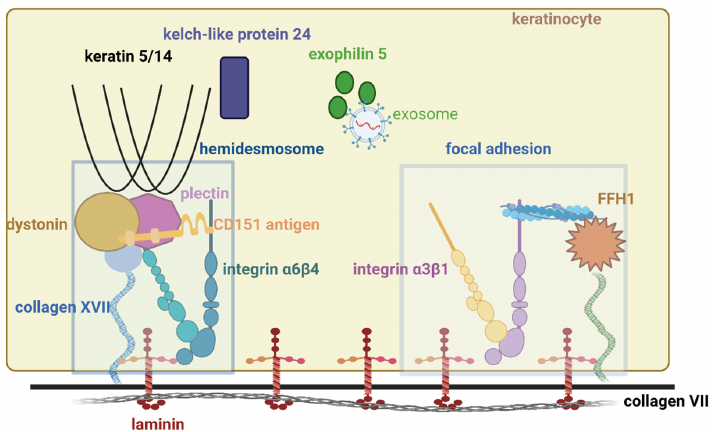
Figure 1. Main proteins involved in epidermolysis bullosa. Created with BioRender.com (accessed 6 April 2022). on 6 April